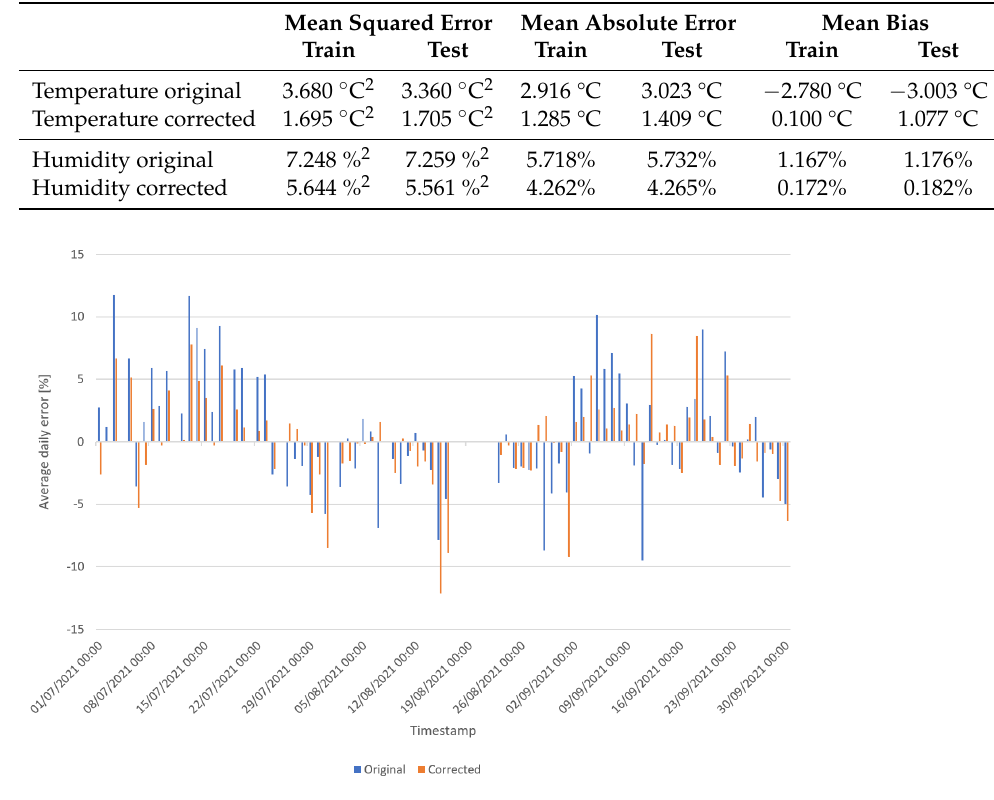
Figure 3. Overview of corrected and original humidity measurements of the testing set in comparison to forecasted humidity by